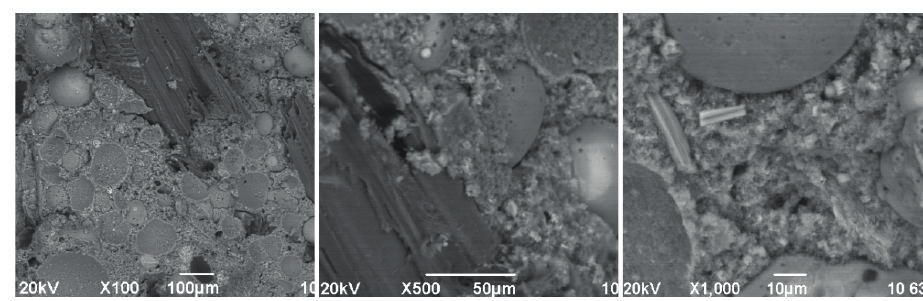
Fig. 4. Microstructure of magnesia composites with a combined